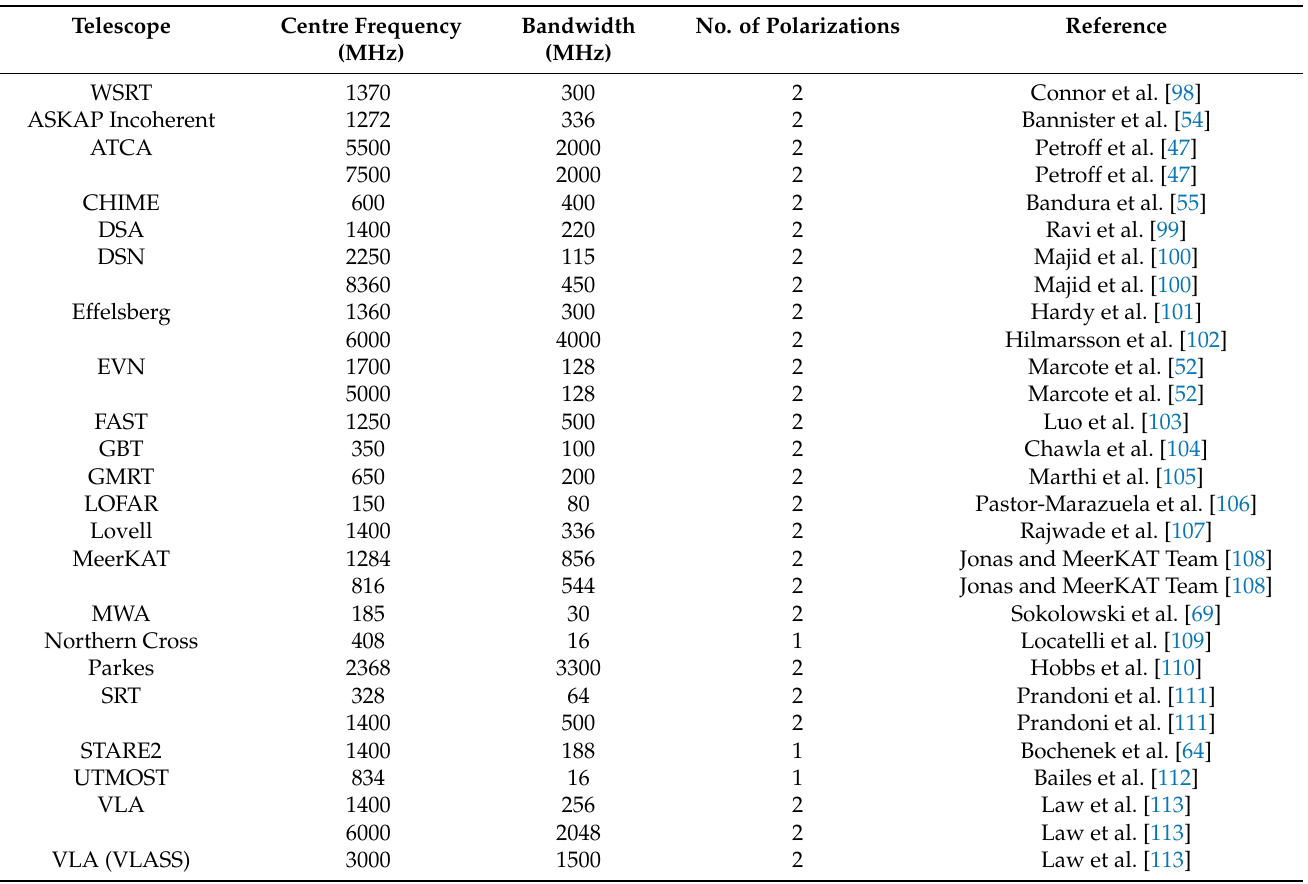
Table 1. Summary of telescopes undertaking FRB surveys and targeted